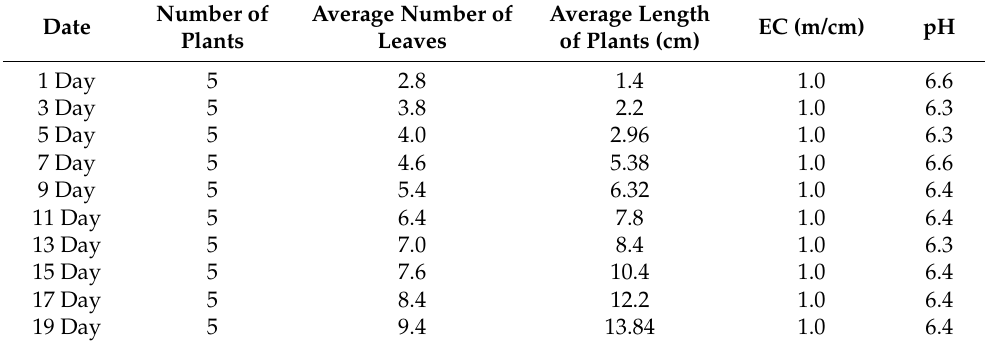
Table 8. Controlled plant growth and systematic observation.